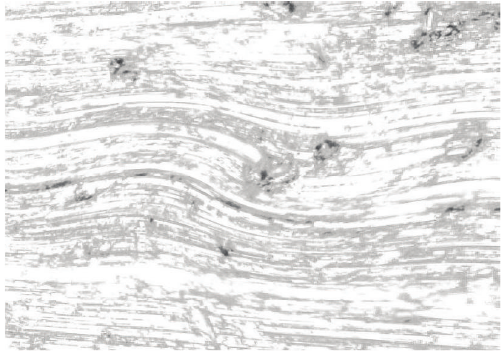
Figure 4: Turbulence in the runner of a high-pressure reversing valve.